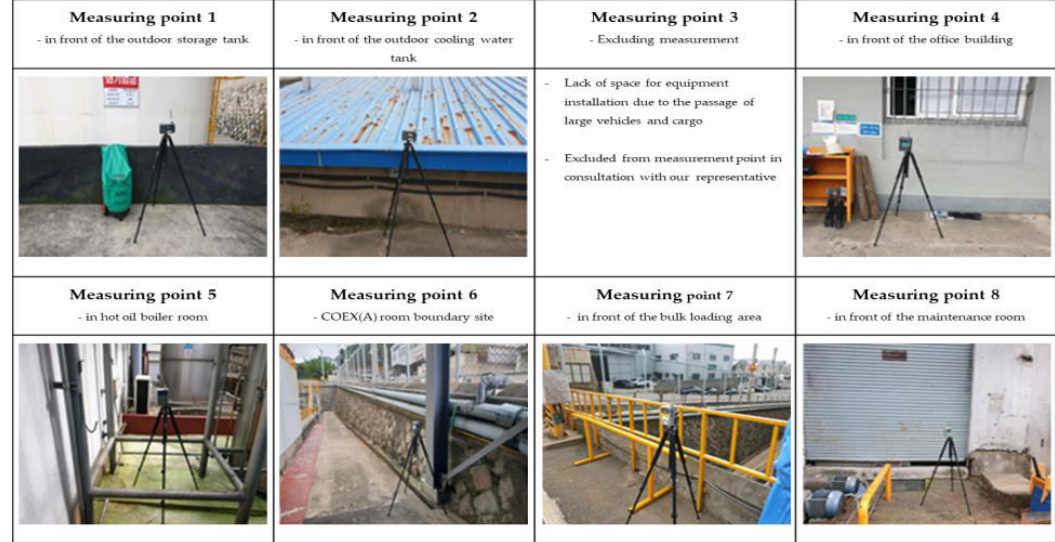
Figure 4. Installation of measurement equipment for research target study site A.